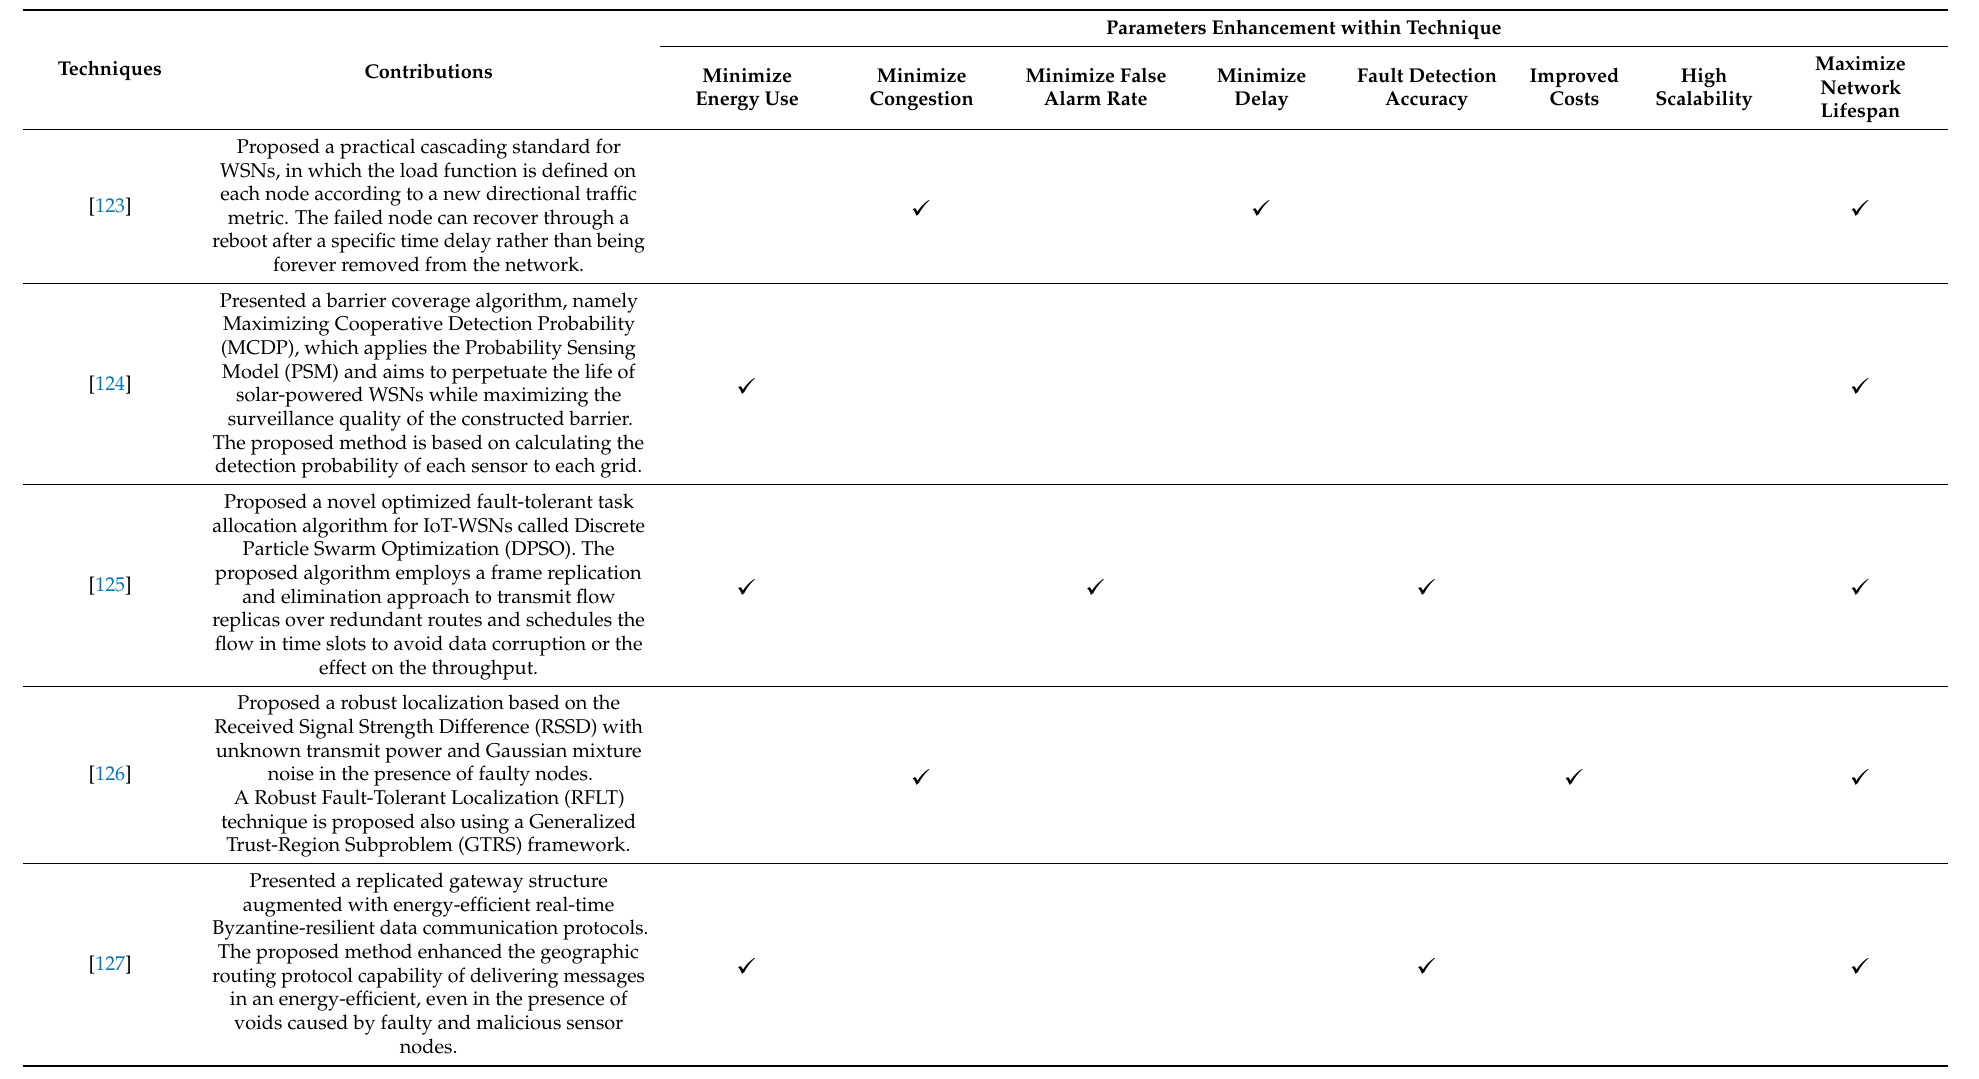
Table A1. Cont. Table 1. Surveys on Fault-Tolerant in WSNs. Table 1. Surveys on Fault-Tolerant in WSNs. Table 1. Surveys on Fault-Tolerant in WSNs.